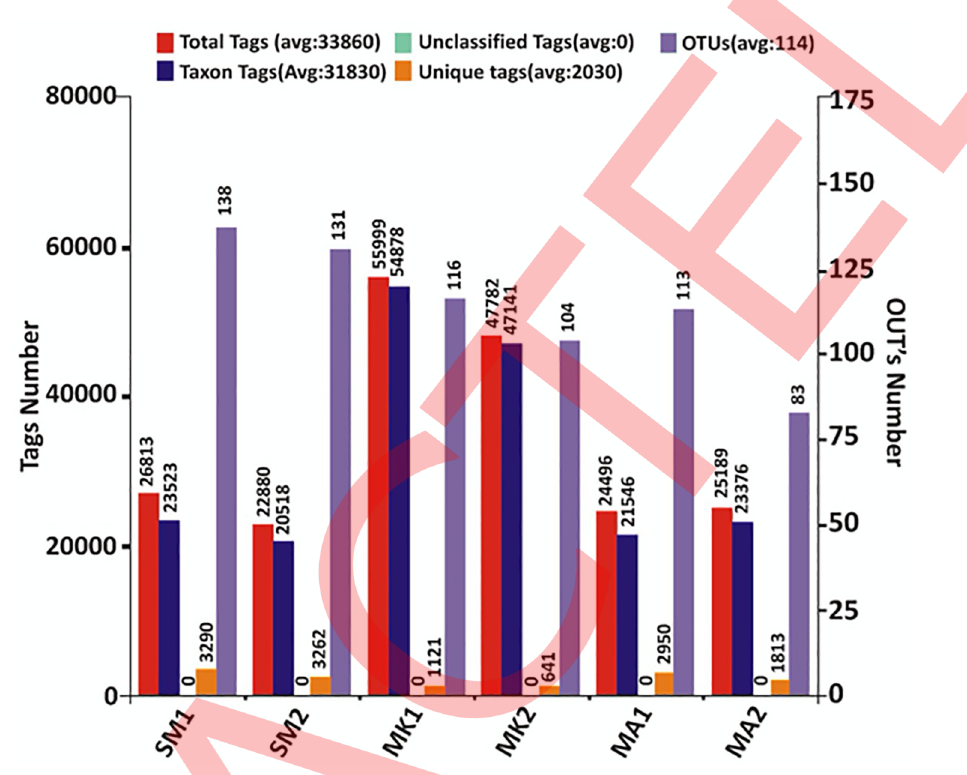
Fig 1. Statistical analysis of the tags and operational taxonomic units of each tested citrus leaf sample.